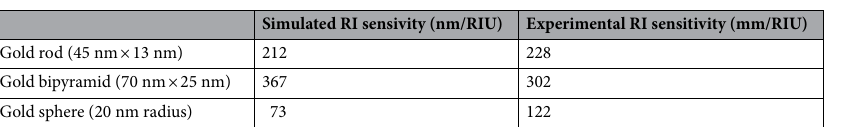
Table 1. Simulated and experimental refractive index sensitivity. Qualitative agreement can be seen between simulated and experimental refractive index